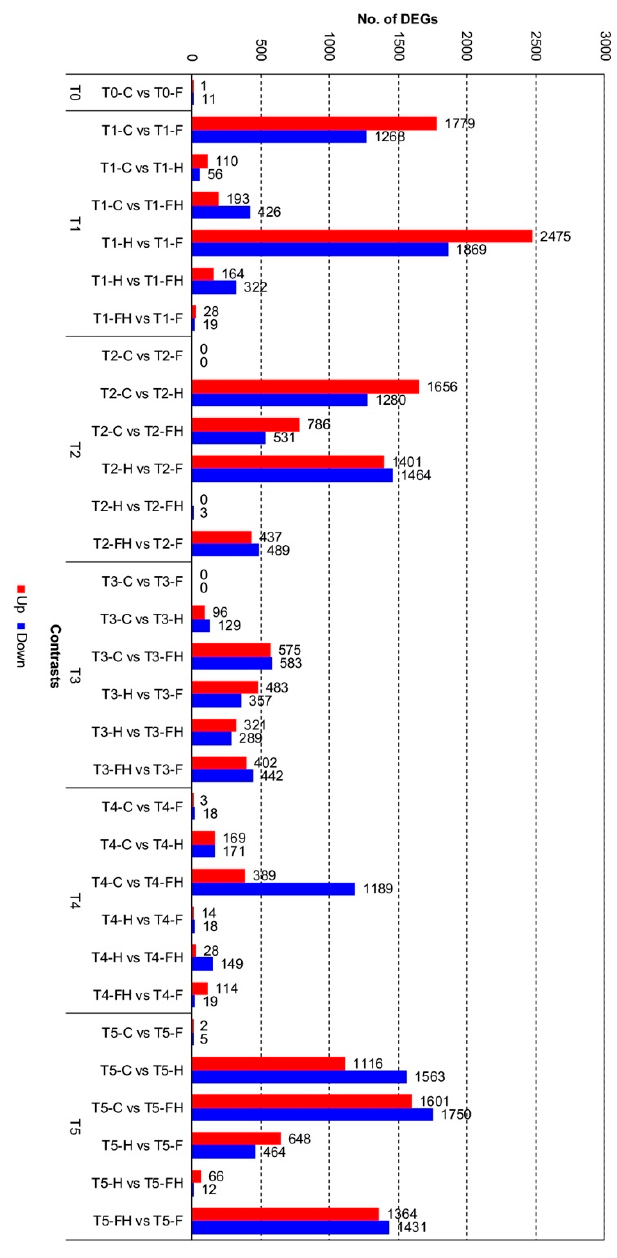
Figure 5. The number of differentially expressed genes (DEGs) in a selected number of contrasts from T0 to T5. Up- (red) and down- (blue) regulated genes are shown for each comparison. Samples within each contrast are named according to the timepoint and treatment (C, control; F, flooded; H, heatwave; FH, flooded plus heatwave).